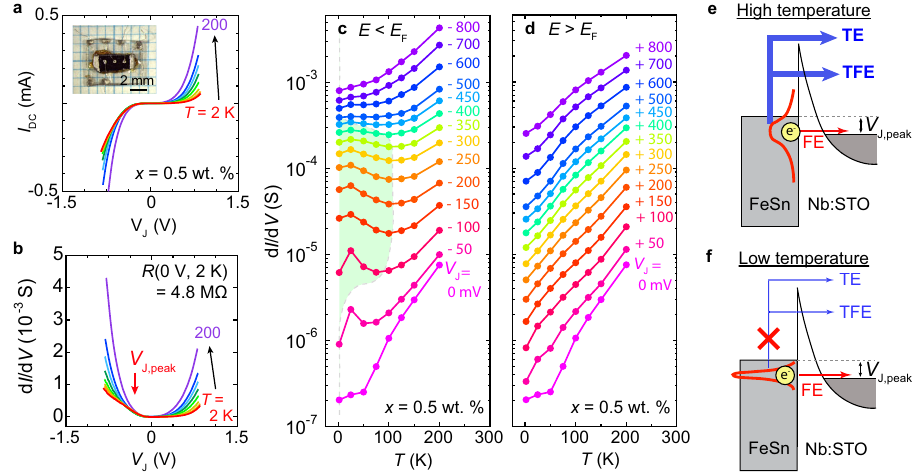
Fig. 2 Temperature-dependent tunneling in a x = 0.5 wt.% junction. a I – V characteristics and b d I /d V spectra at different temperatures for the FeSn/ Nb:STO junction with x = 0.5 wt. %. The measurements were taken at T = 2, 25, 50, 75, 100, 125, 150, 200 K. The inset in a is an optical micrograph of the measuring device. The red arrow in b marks V J,peak , the position of the broad peak in d I /d V at low temperature. c , d Temperature-dependent d I /d V for negative and positive V J for the x = 0.5 wt.% junction. The green-shaded area denotes the region in which d I /d V increases as temperature decreases. e , f Schematic of the tunneling mechanisms across the Schottky barrier. Non-resonant thermionic emission (TE) and thermionic fi eld emission (TFE) processes dominate in the high-temperature regime, whereas resonant fi eld emission (FE) process through the barrier dominates in the low-temperature regime.